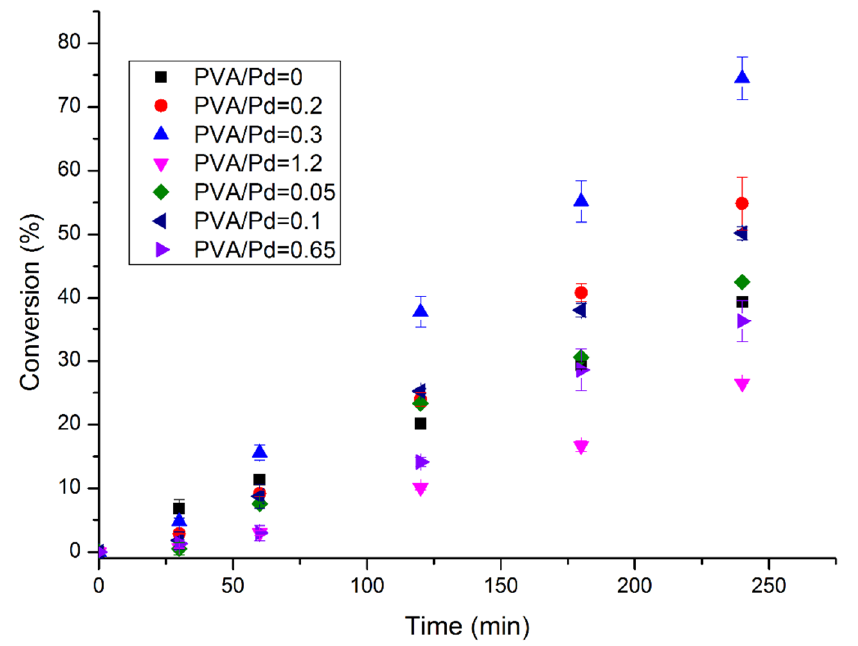
Figure 2. Formic acid dehydrogenation reaction. Effect of the stabiliser. Reaction conditions: 0.5 M HCOOH, substrate/metal molar ratio: 2000:1, 50 °C, 750 rpm, 4 h reaction time.